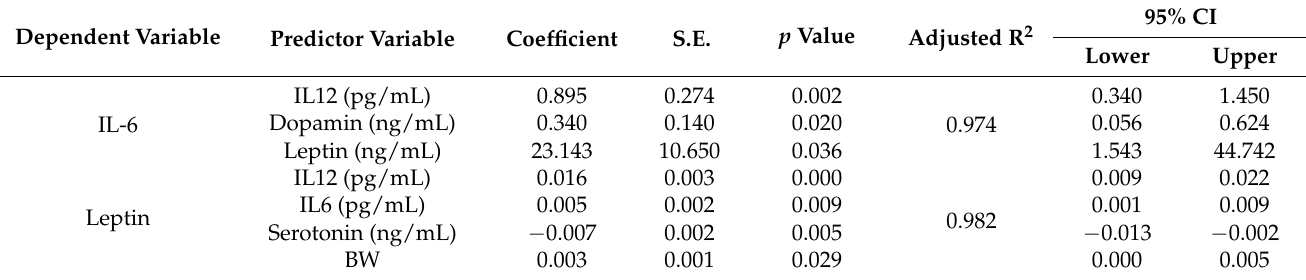
Figure 3. Effect of the independent and synergistic effects of Curcuma and Mangosteen extracts on brain neurotransmitters in lean and HFT-induced obese rats. The mean and SEM are indicated in black. Significance was determined using a one-way ANOVA with a Tukey post-hoc test. ns: not significant. Table 4. Multiple Regression using the Stepwise method for the measured variables.